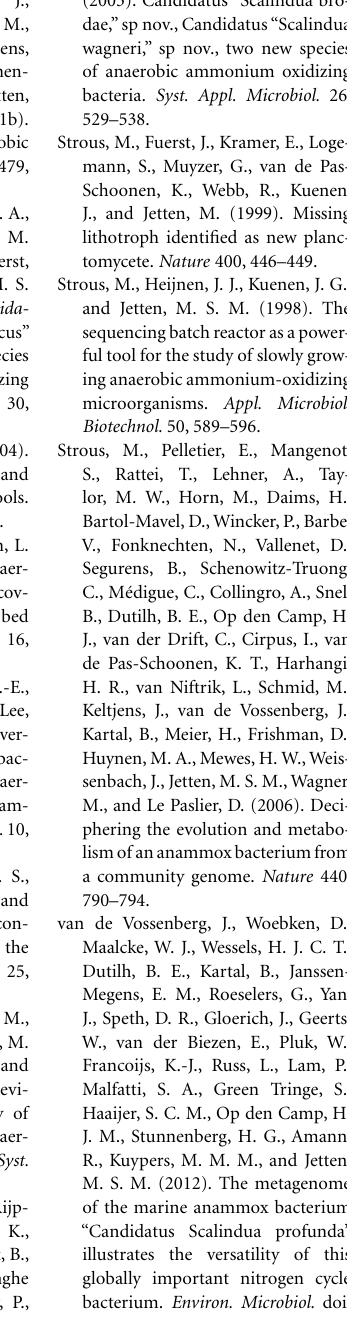
Table S1 | Genes specifically absent from CH1.